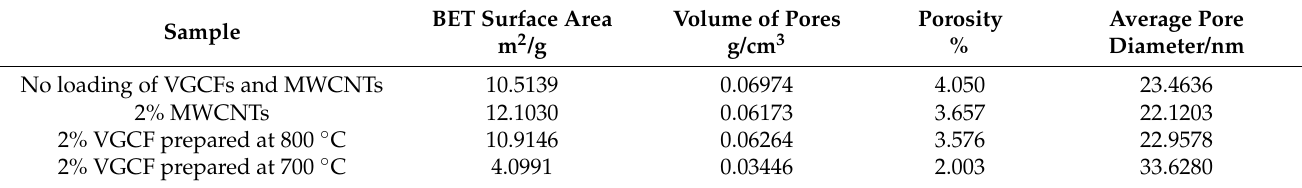
Table 2. The specific surface area, pore volume, porosity and average pore diameter of BPs with different